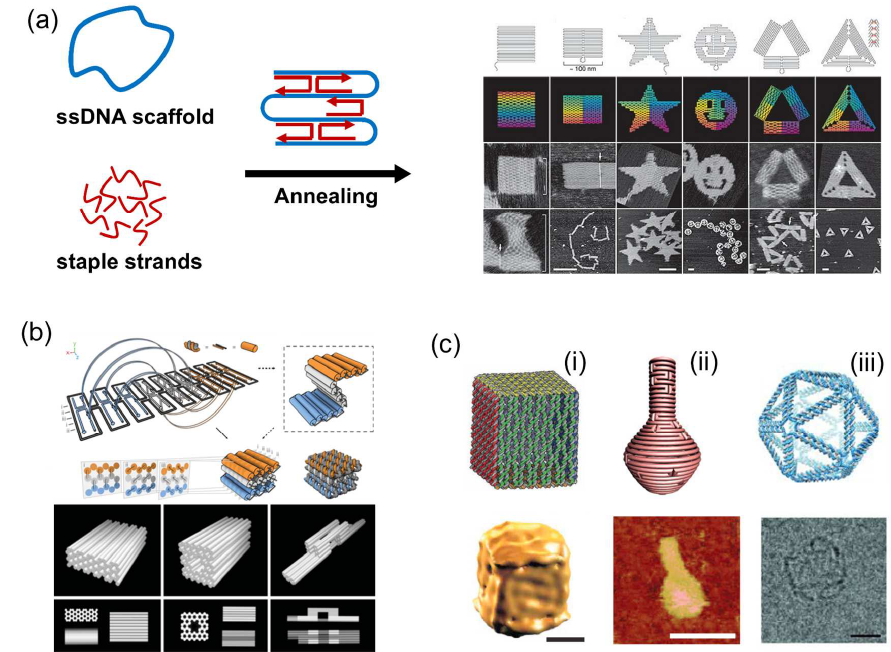
Figure 3. DNA origami technique and DNA origami scaffolds. ( a ) DNA origami using a circular single-stranded DNA template (7 kb) that folds into predesigned shapes with the aid of DNA staple strands [14]. ( b ) Design and folding of three-dimensional DNA origami structures [15]. ( c ) Examples of three-dimensional DNA origami structures. ( i ) A DNA origami box ant its Cryo-EM image, scale bar: 20 nm [53]. ( ii ) A DNA nanoflask and its AFM image, scale bar: 75 nm [54]. ( iii ) A 3D DNA spherical structure and its TEM image, scale bar: 10 nm [55]. Reprinted